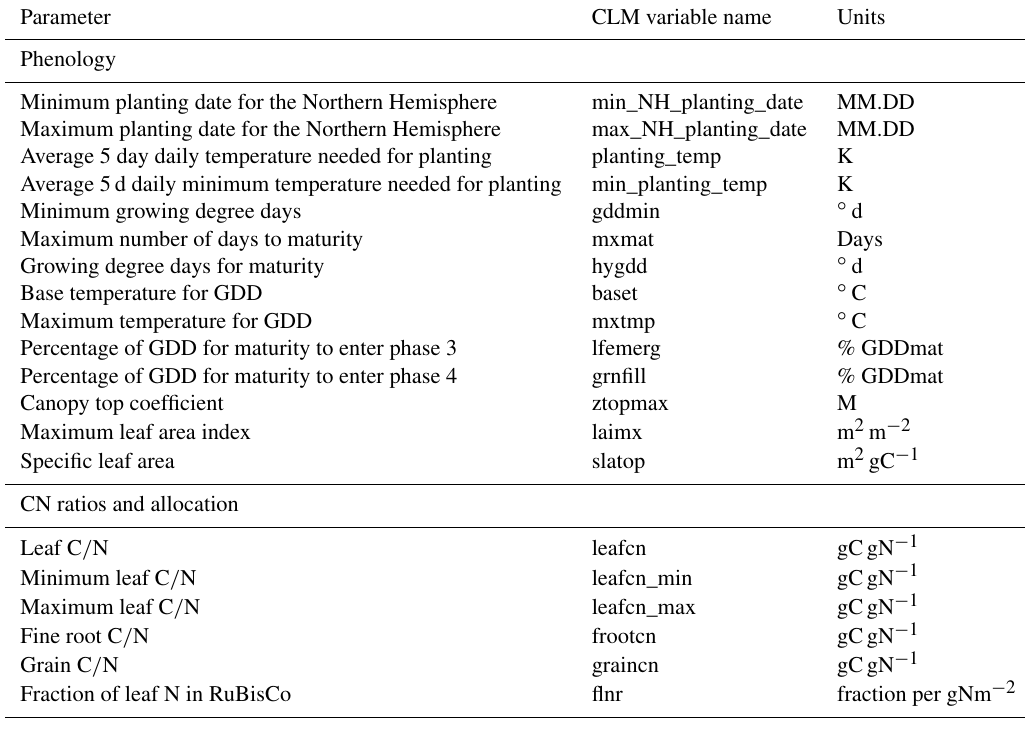
Table 1. CFT-specific phenology, carbon and nitrogen ratios, and allocation